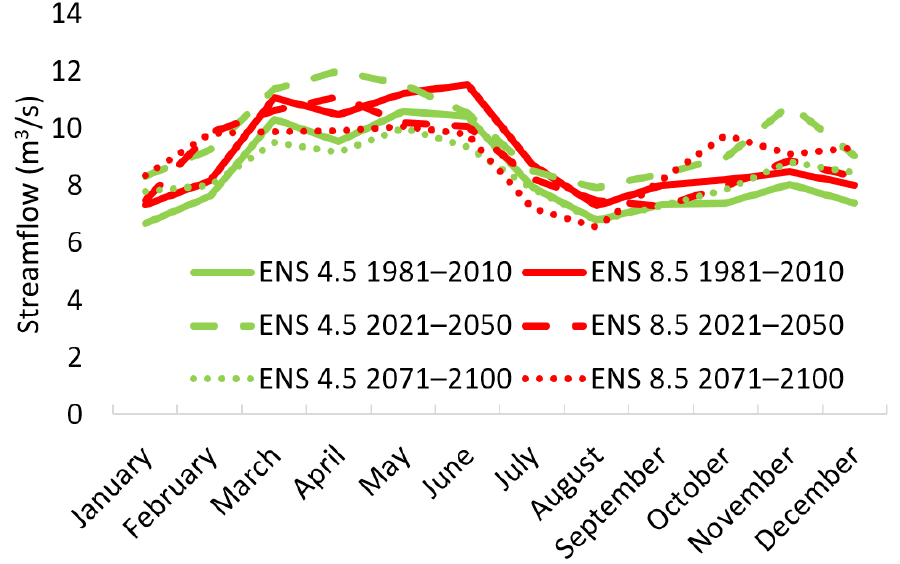
Figure 5. Streamflow at the catchment outlet for the representative monthly year for each climate model output for the reference, short- and long-term periods.